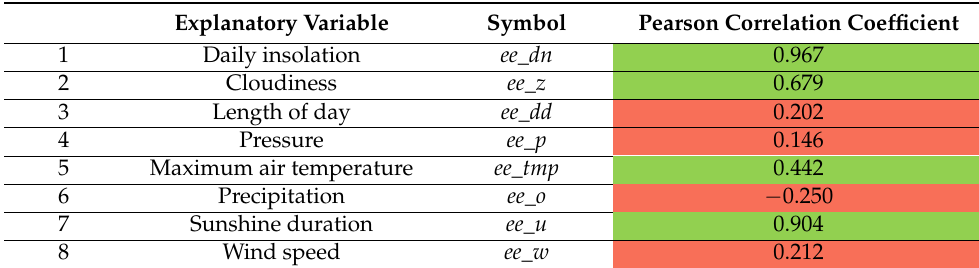
Table 2. Values of Pearson correlation coefficients determined for the selected explanatory variables and the response variable.